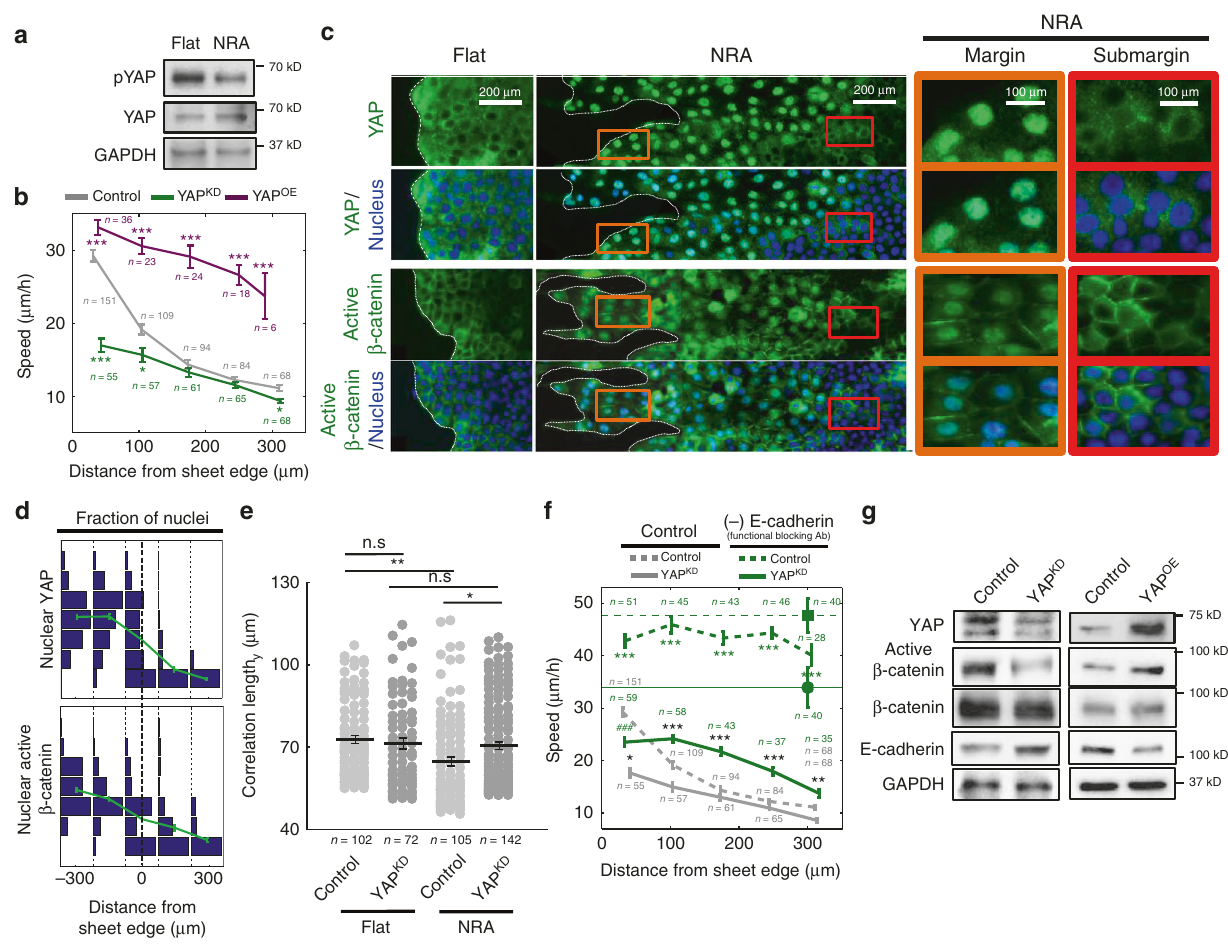
Fig. 2 Switch-like regulation of YAP in expanding epithelial layers loosening cell – cell adhesion. a Cells on fl at substrata and NRA analyzed by immunoblotting using YAP and phosphorylated YAP antibodies. b Cell migration speed of individual YAP KD and YAP OE cells in cell sheets as a function of the distance from the sheet edge on NRA (each number of independently analyzed cells, n , is indicated, * = statistical signi fi cance of speed of control vs. YAP KD cells on NRA (green) and of control vs. YAP OE cells on NRA (purple), * P < 0.05, ** P < 5 × 10 − 4 , and *** P < 5 × 10 − 6 ). c Immuno fl uorescence staining for YAP and active β -catenin in epithelial cell sheets on fl at substrata and NRA. Translocation of YAP and active β -catenin into nuclei observed in marginal zones and FLPs of sheets expanding on NRA (brown boxes) and mostly cytoplasmic YAP and active β -catenin localization in submarginal cells on NRA (red boxes) and on fl at substrata. The samples were analyzed after 8 h from the initiation of sheet expansion. d Fractions of nuclei displaying different intensities of YAP and active β -catenin staining as a function of the distance from the sheet edge determined at 8 h after initiation of sheet expansion (the edge is coincident with the concave regions at the bases of FLPs in panel c ). e Velocity correlation length in y-direction, parallel to the direction of epithelial expansion for the control and YAP KD cells on fl at substrata and NRA (each number of independently analyzed cells, n , is indicated, * = statistical signi fi cance of correlation length, * P < 0.05, ** P < 0.01, and n.s = no signi fi cance). f Cell migration speed of individual cells in cell sheets as a function of the distance from the sheet edge on fl at substrata and NRA, in the presence of an E-cadherin functional blocking antibody. Dashed line with a square marker indicates the average cell migration speed of isolated control cells and solid line with a circle marker corresponds to that of isolated YAP KD cells (each number of independently analyzed cells, n, is indicated, # = statistical signi fi cance of speed values in the marginal region vs. the most submarginal region of YAP KD cells with drugs, ### P < 5 × 10 − 6 . * = statistical signi fi cance of control vs. YAP KD cells with drugs (green) and of YAP KD cells with vs. without drugs (black), * P < 0.05, ** P < 5 × 10 − 4 , and *** P < 5 × 10 − 6 ). g Control, YAP KD , and YAP OE cells were immunoblotted using active β -catenin and